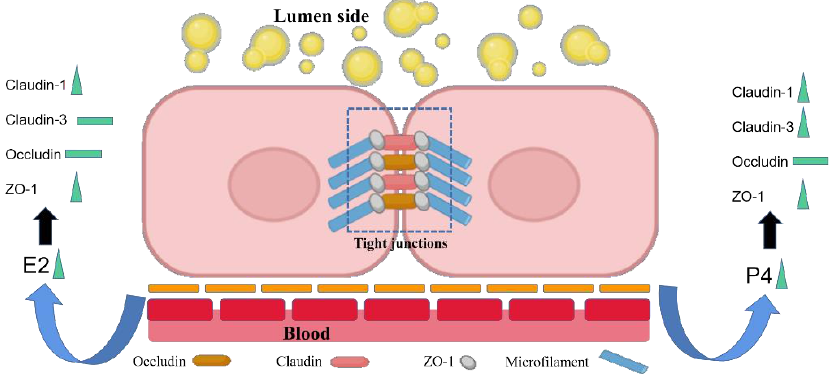
Figure 5. The diagram illustrating the function of E 2 and P 4 on the tight junction proteins showed that the targets were increased; therefore the tight junction proteins did not change. that the targets were increased; therefore the tight junction proteins did not